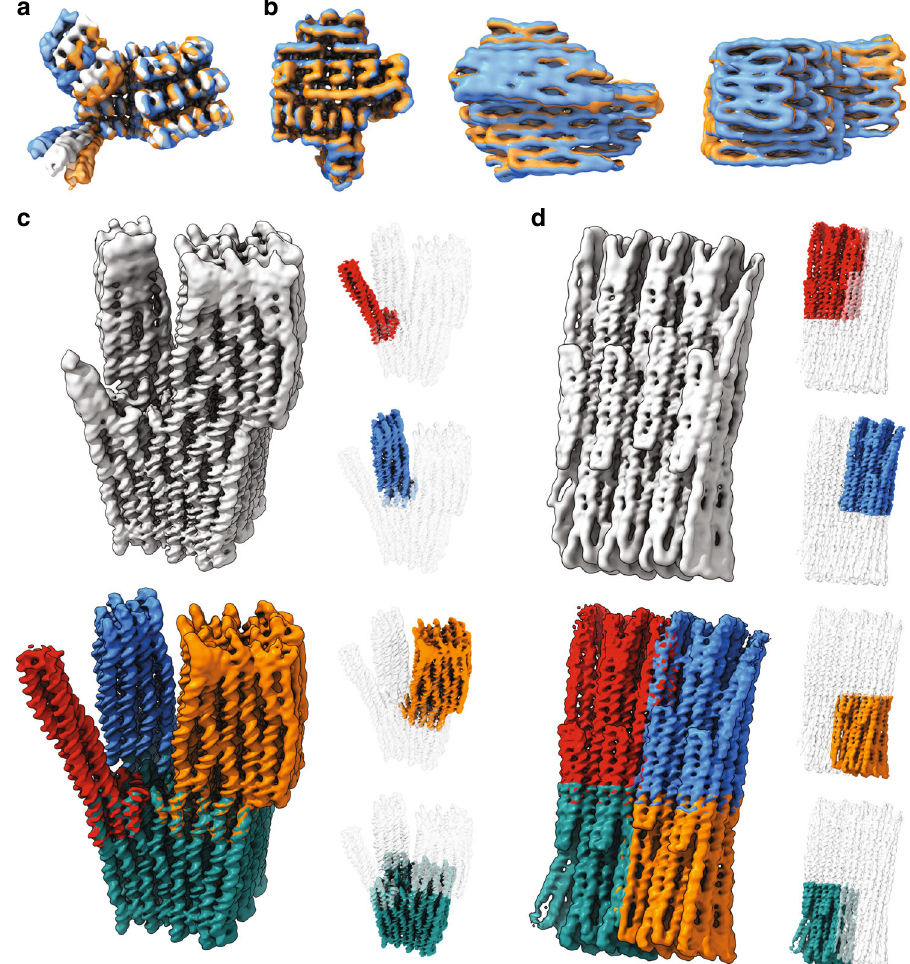
Fig. 3 Domain motions and lattice breathing in DNA origami. a Overlay of three exemplary 3D classes determined from the Twisttower dataset. b Overlay of exemplary 3D frames of a principal component analysis (PCA) of the heterogeneity in the Pointer-v2 dataset. c Top left: cryo-EM map determined treating the Twisttower as one rigid body. Right: cryo-EM maps of subbodies analyzed using multibody re fi nement. Bottom left: Frankenstein map. d As in c , but for a 48-helix-brick object, with an arbitrary division into four